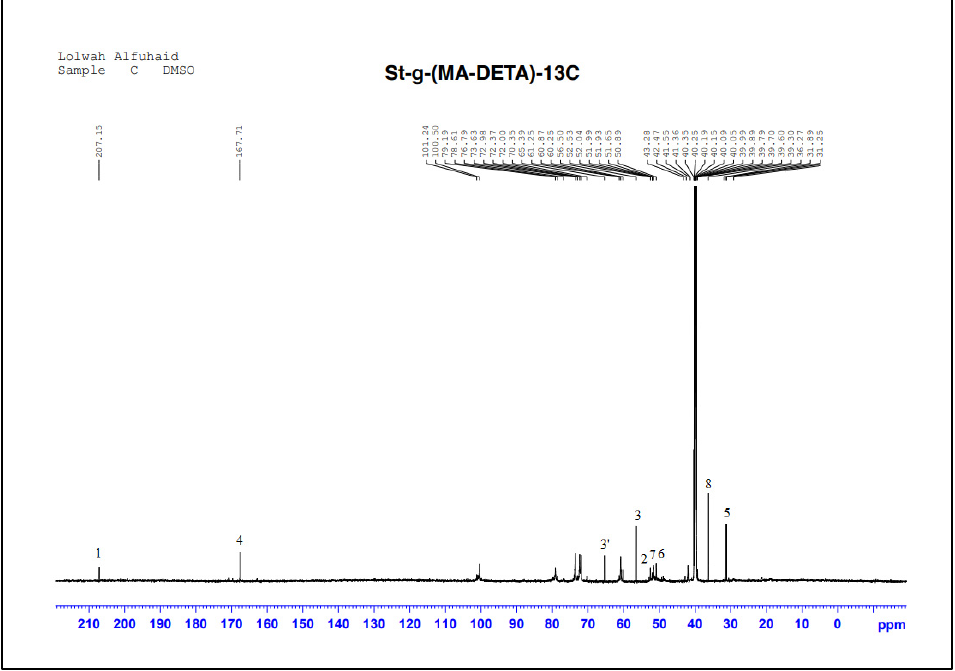
Figure 8. 13 C-NMR chemical shifts of the St-g-(MA-DETA).